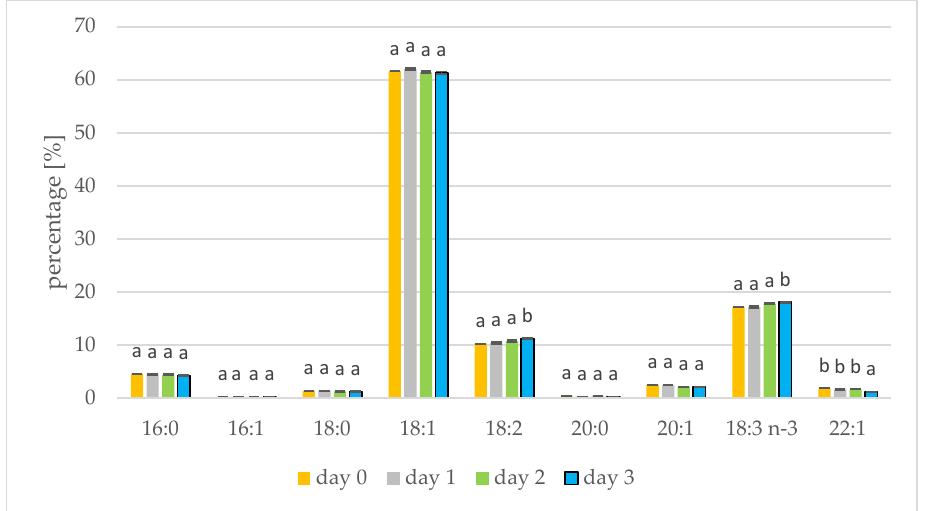
Figure 2. Fatty acid composition [%] of mustard oil on days 1, 2 and 3 of germination. 16:0—palmitic acid; 16:1—palmitoleic acid; 18:0—stearic acid; 18:1—oleic acid; 18:2—linoleic acid; 20:0—arachidic acid; 20:1—eicosenoic acid; 18:3 n ‐ 3—linolenic acid; 22:1—erucic acid (values are means ± SD from three experiments. Values with different letters are significantly different ( p < 0.05)).